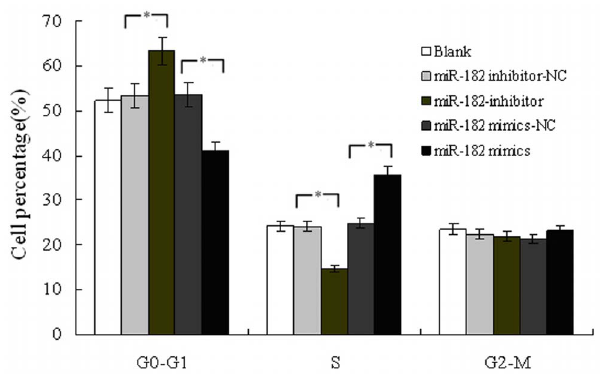
Figure 6. Analysis of cell cycle in PC3 cells after transfected with miR-182 mimics or inhibitors. Blank presents blank control. Values represent means from three separate experiments and error bars represent the SD. (* P ,